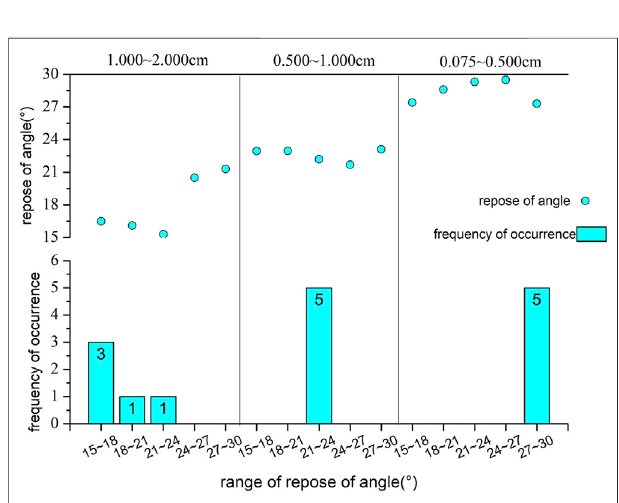
FIGURE8| Stackingtestresultsandangleofreposedistributionwithout vibration.